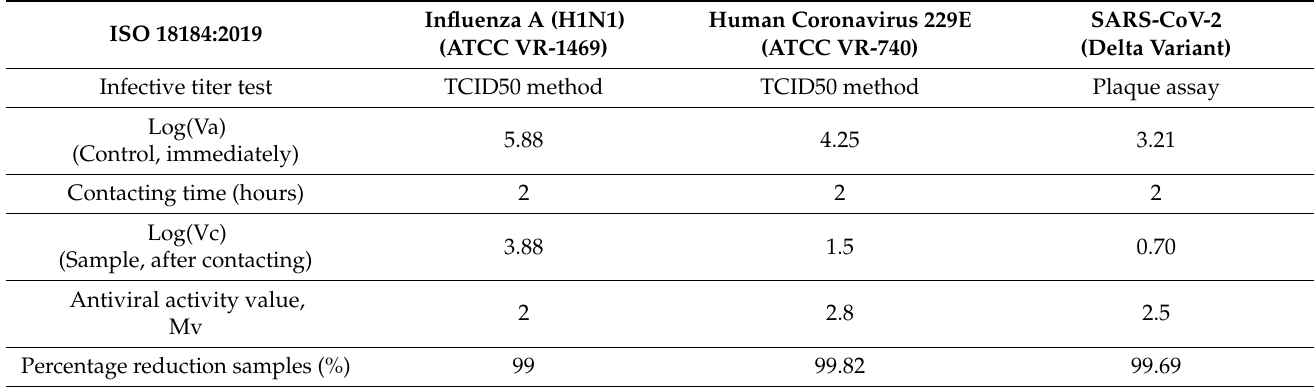
Table 6. Antiviral reduction rate of PLA NF filter media containing manuka triketone (5 wt.%) against influenza A, human coronavirus 229E and SARS-CoV-2 tested according to ISO 18184:2019 [44].